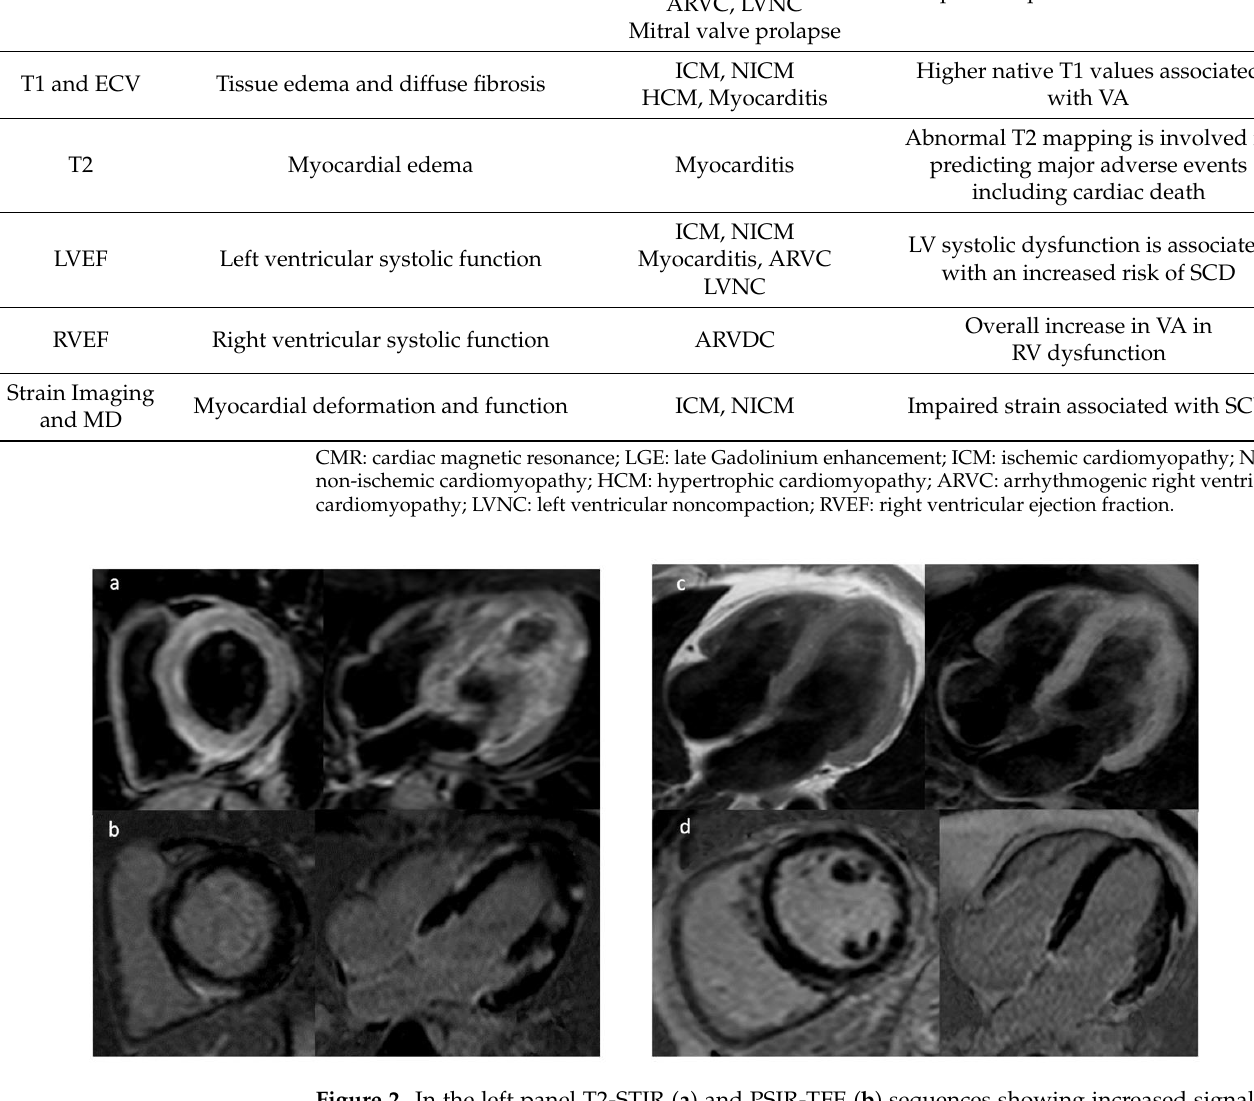
Figure 2. In the left panel T2-STIR ( a ) and PSIR-TFE ( b ) sequences showing increased signal pre- dominantly subepicardial patchy of the left ventricular wall due to necrosis of acute myocarditis. In the right panel sequence T1-TSE and T1-Fat Sat ( c ) showing multiple areas of adipose infiltration with mesocardial and subepicardial distribution of the left ventricle walls, ( d ) extended subepicardial signal hyperintensity in PSIR sequences for the study of “Late Gadolinium Enhancement” indicative of fibrosis for Left Dominant Arrhythmogenic Dysplasia.